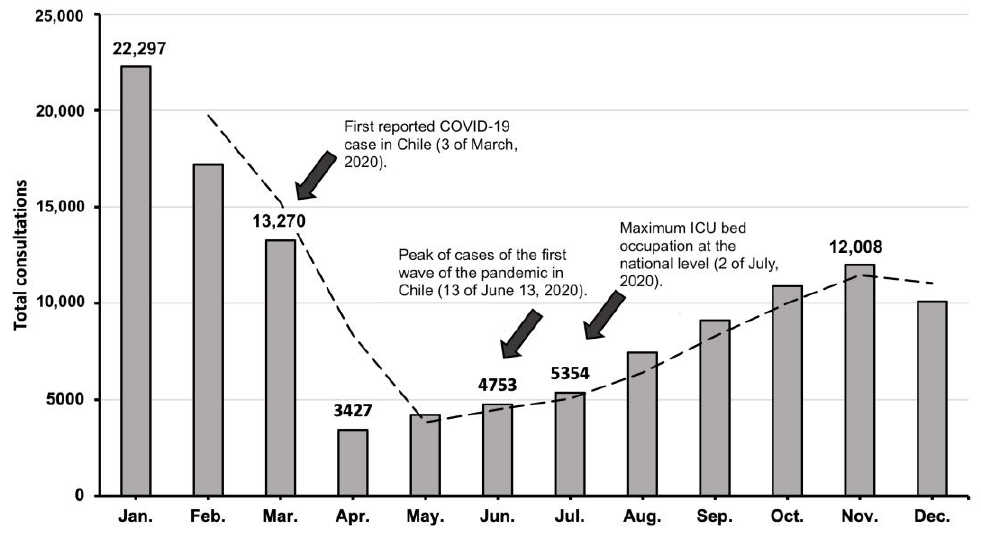
Figure 4. Monthly temporal progression of dermatology consultations during 2020 and its correlation with the epidemiological situation of the country at the time.